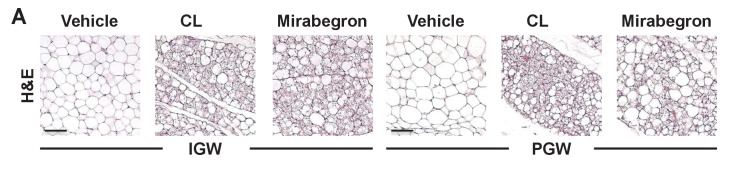
Induction of beige adipocytes by CL316,243 and mirabegron.(A) Representative H&E staining of IGW and PGW depot sections from two-month-old male mice were treated with vehicle, CL or mirabegron for seven days (n= 6/group). Scale bar = 100 µm.